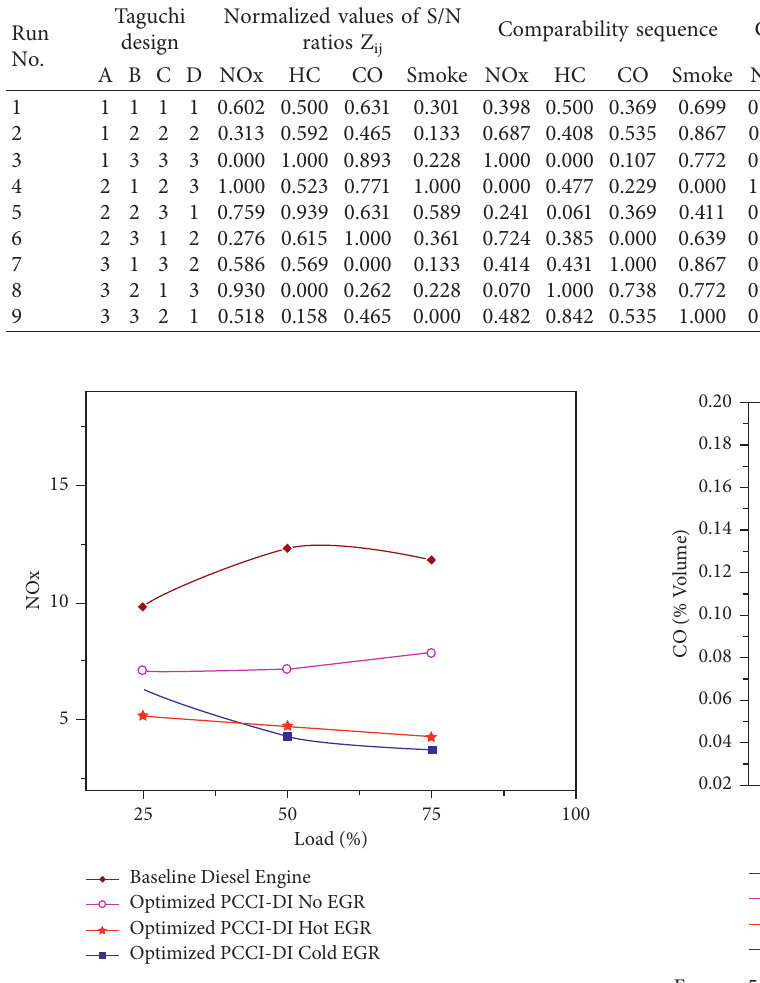
Figure 3: Effect of EGR configurations on NOx versus load.